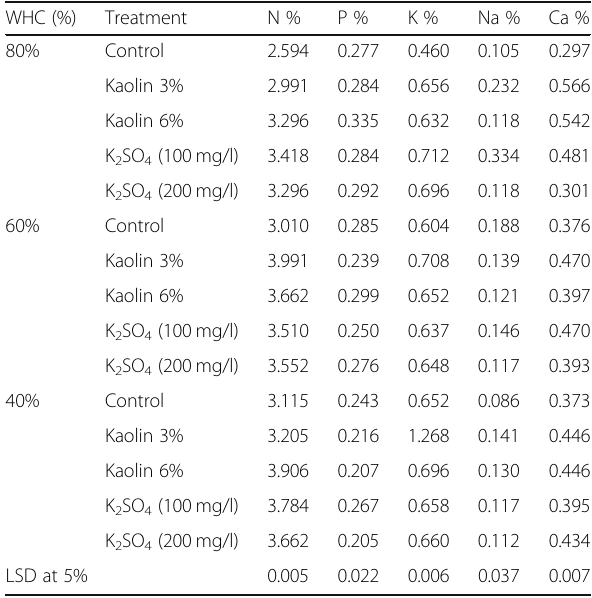
Table 6 Effect of different concentrations of kaolin or K under different levels of water holding capacity on N, P, K, Na, and Ca percentage of wheat plants after 75 days from sowing (combined analysis of two seasons) WHC (%) Treatment N %